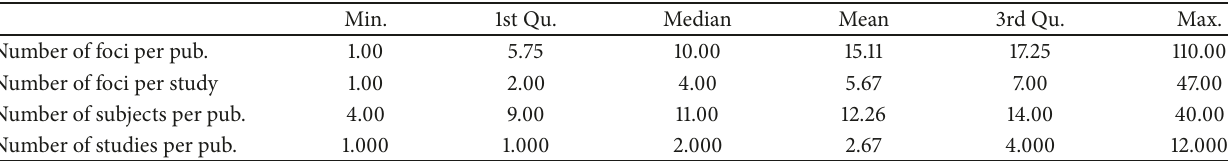
Table 4: Descriptive statistics ∗ .